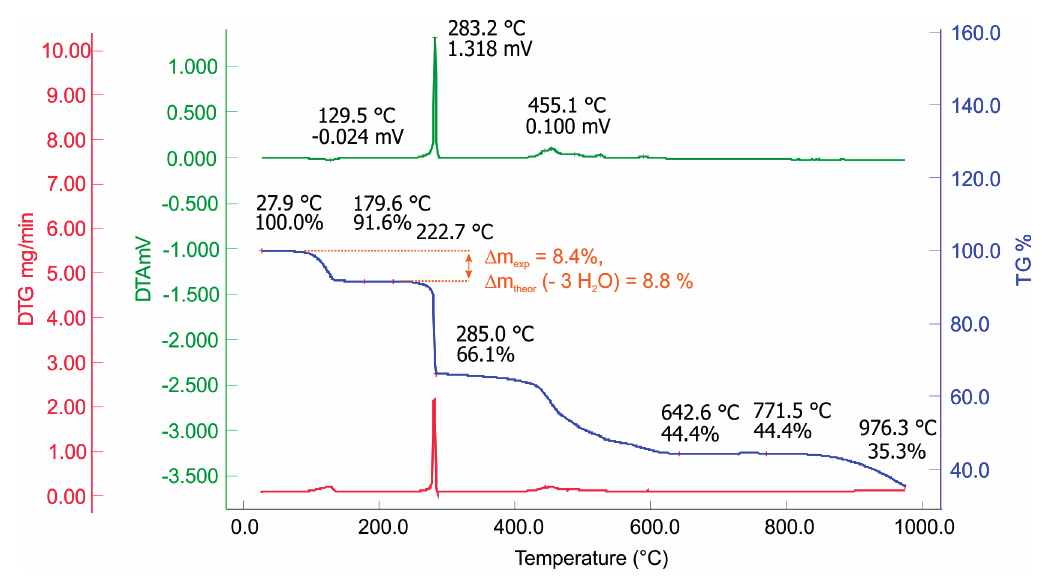
Figure 10. DTA/TG/DTG curves for complex 4